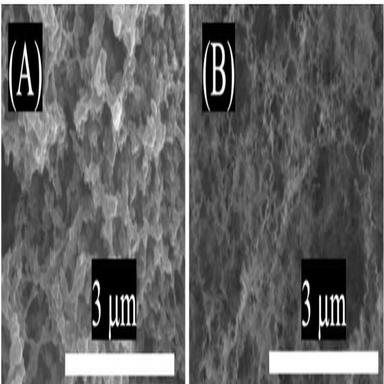
SEM of fibrous structures in S2 (A) and S3 (B).